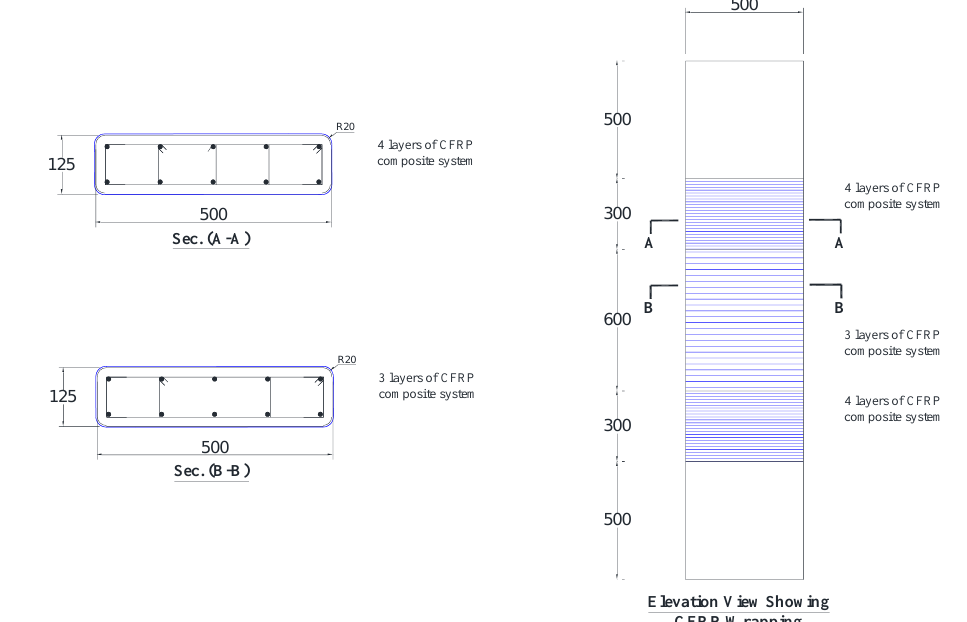
Figure 1. Dimensions and reinforcement detailing of control specimen CW (note: all dimensions are in mm).